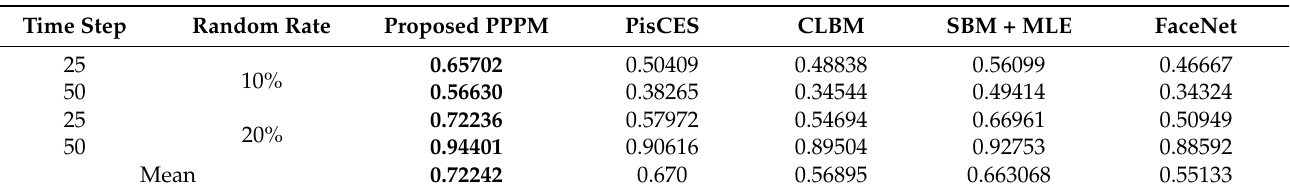
Table 2. The results of the proposed PPPM and representative model on the Mean ARI (synthetic data).